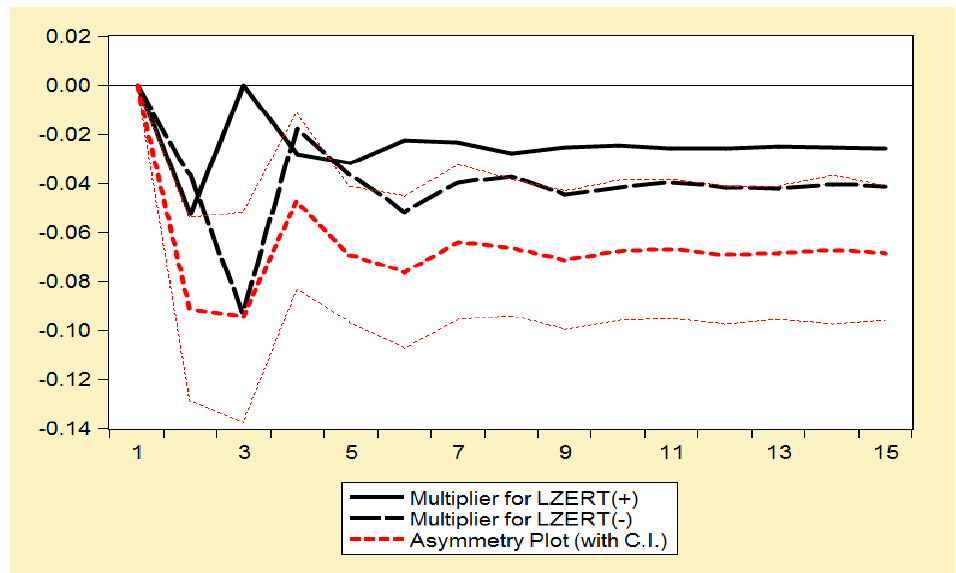
Figure 5. Dynamic Multiplier graph for LREC.